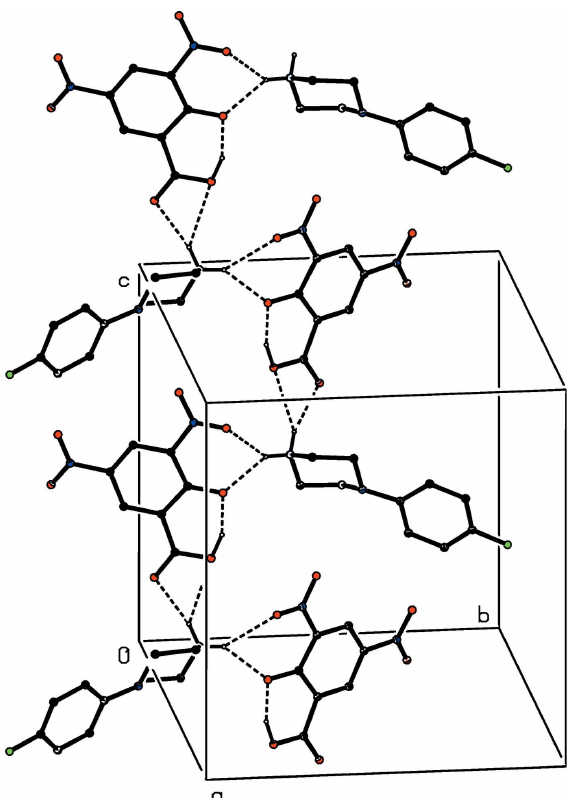
Figure 5 Part of the crystal structure of compound (II) showing the formation of a hydrogen-bonded chain of rings running parallel to the [010] direction. Hydrogen bonds are drawn as dashed lines and, for the sake of clarity, the H atoms bonded to C atoms have been